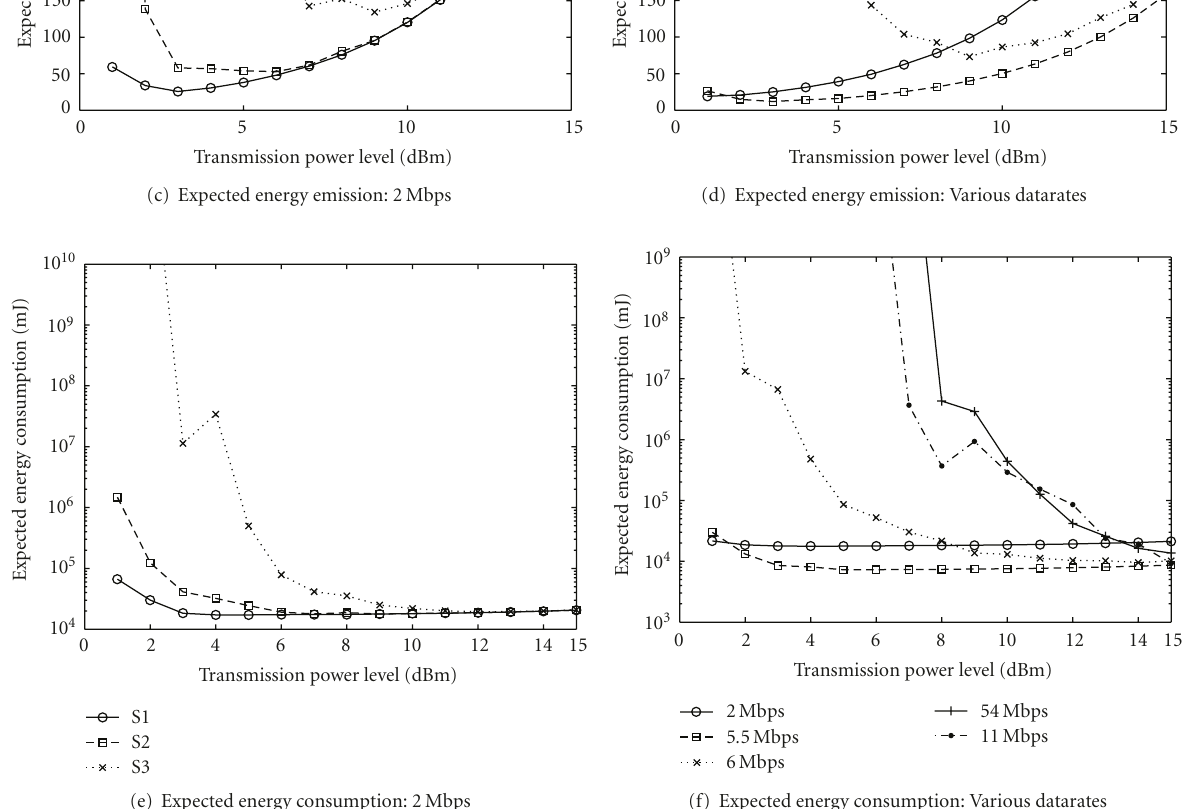
Figure 2: The PDR-table and expected energy emission and consumption for IEEE